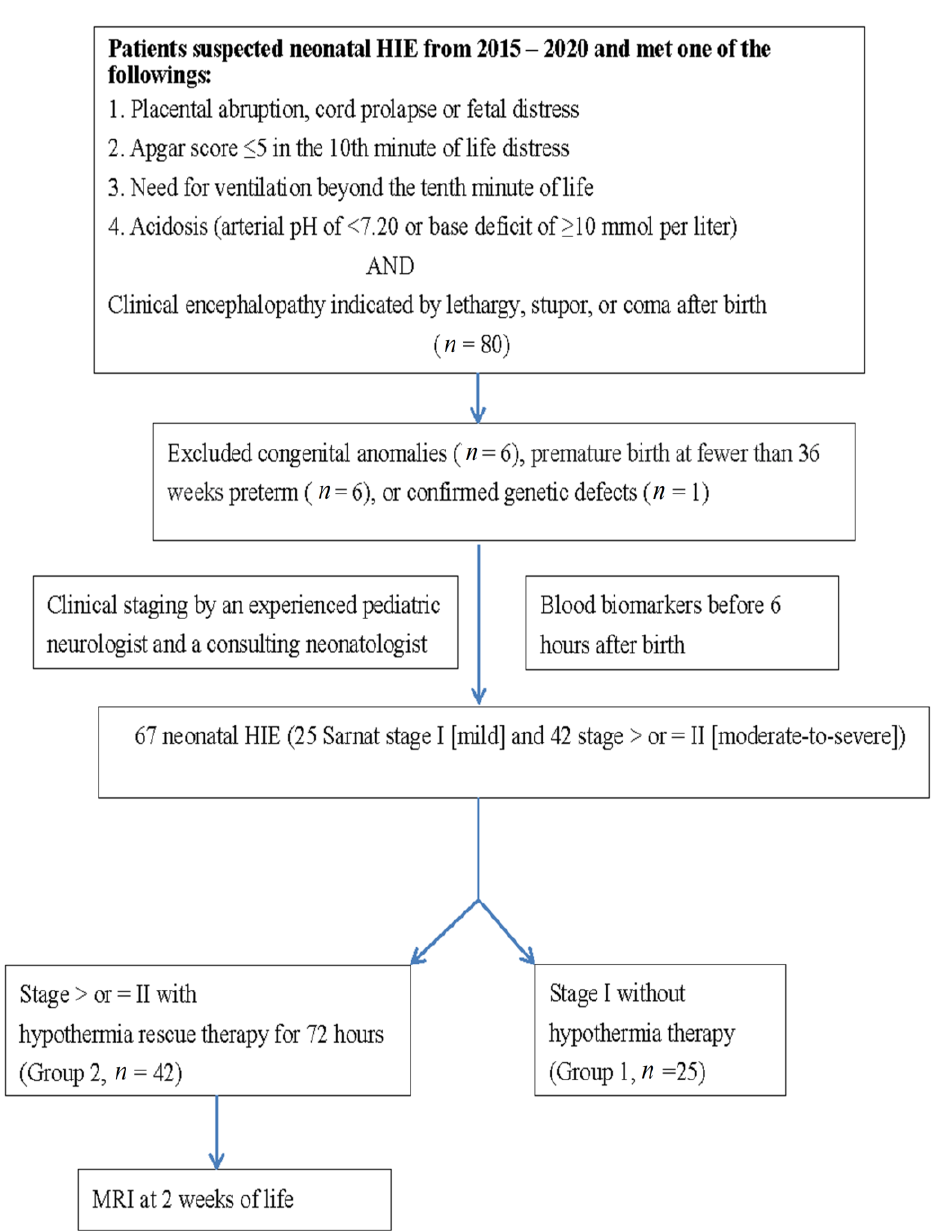
Figure 1. Flow chart of the study procedure. HIE indicates hypoxic-ischemic encephalopathy; MRI, magnetic resonance imaging.